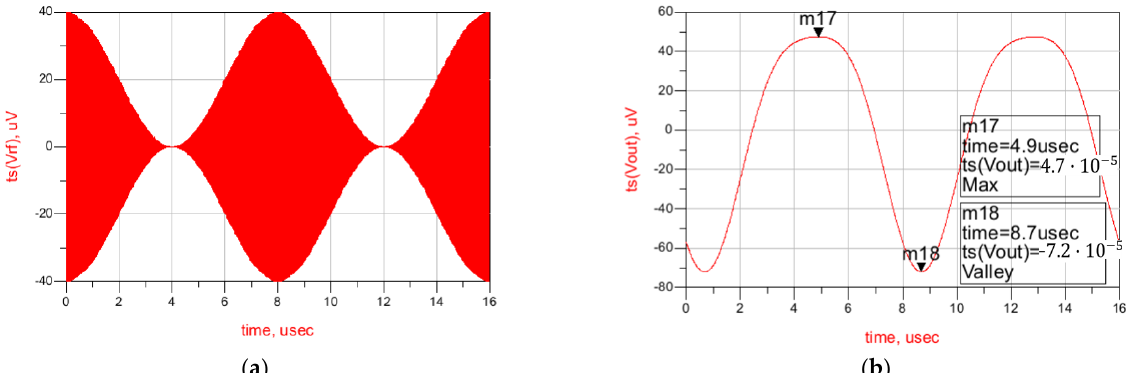
Figure 11. Time-domain simulation results of the current-reuse feedback WuR with amplification and low-pass filtering stages. Input ( a ) and output signals ( b ).